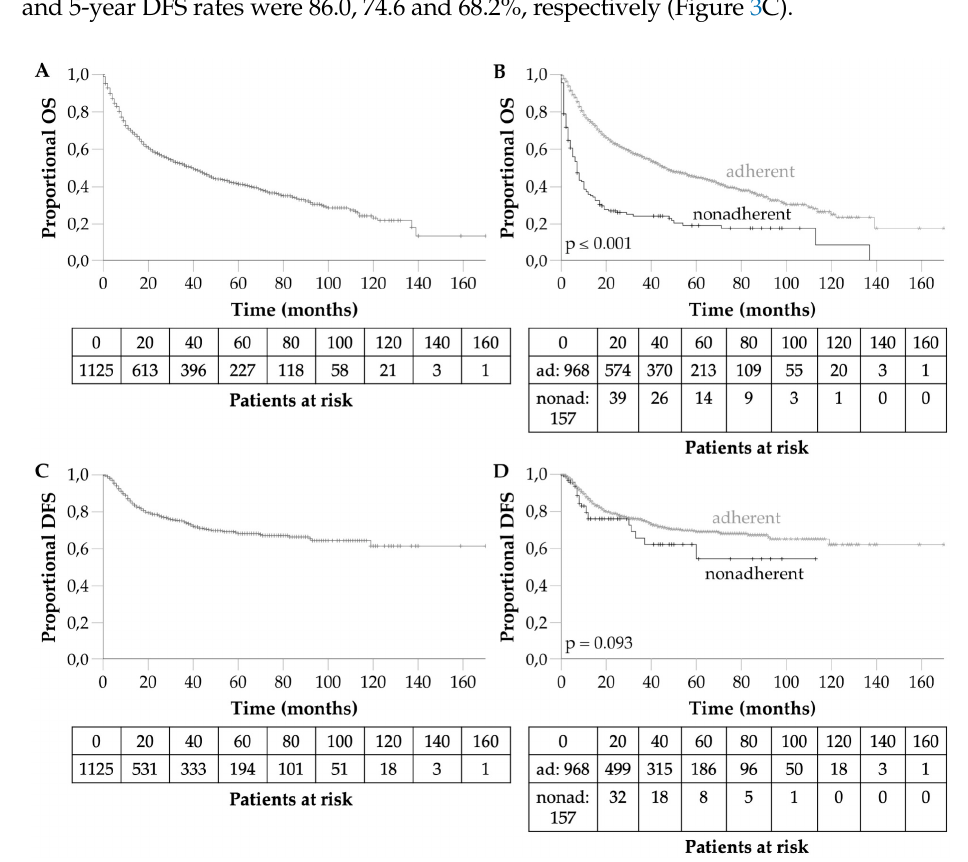
Figure 3. ( A ). Overall survival of the 1125 patients with HNSCC ≥ 70 years. ( B ). Overall survival depending on adherence. ( C ). Disease-free survival of the 1125 patients with HNSCC ≥ 70 years. ( D ). Disease-free survival depending on adherence. Ad, adherent; nonad, nonadherent.